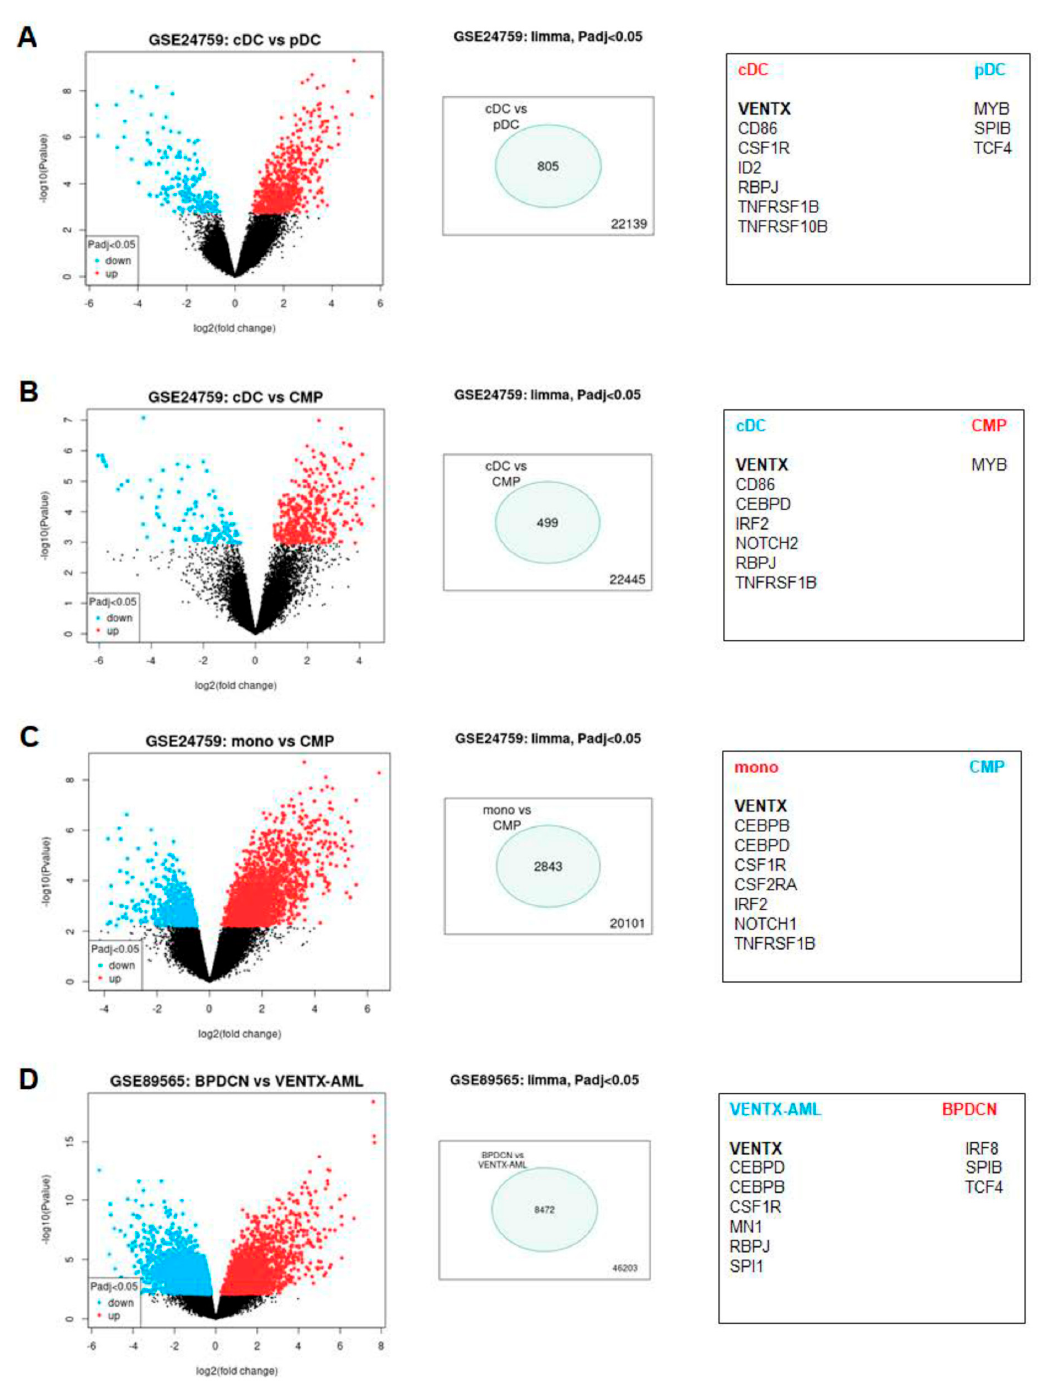
Figure 3. Identification of potential regulators of VENTX. Dataset GSE24759 was analyzed to identify significant differ- entially expressed genes between VENTX-positive and VENTX-negative hematopoietic entities. We used the online tool GEOR and compared ( A ) cDC versus pDC, ( B ) cDC versus common myeloid progenitors (CMP), and ( C ) monocytes versus CMP. ( D ) Dataset GSE89565 was used for comparison of six VENTX-positive AML versus 12 BPDCN patient samples. The results are presented as volcano-blot on the left, showing significant genes in blue and red. The numbers of significantly differently expressed genes are indicated in the middle. Selected gene candidates for each analyzed entity are listed on the right. VENTX is highlighted in bold